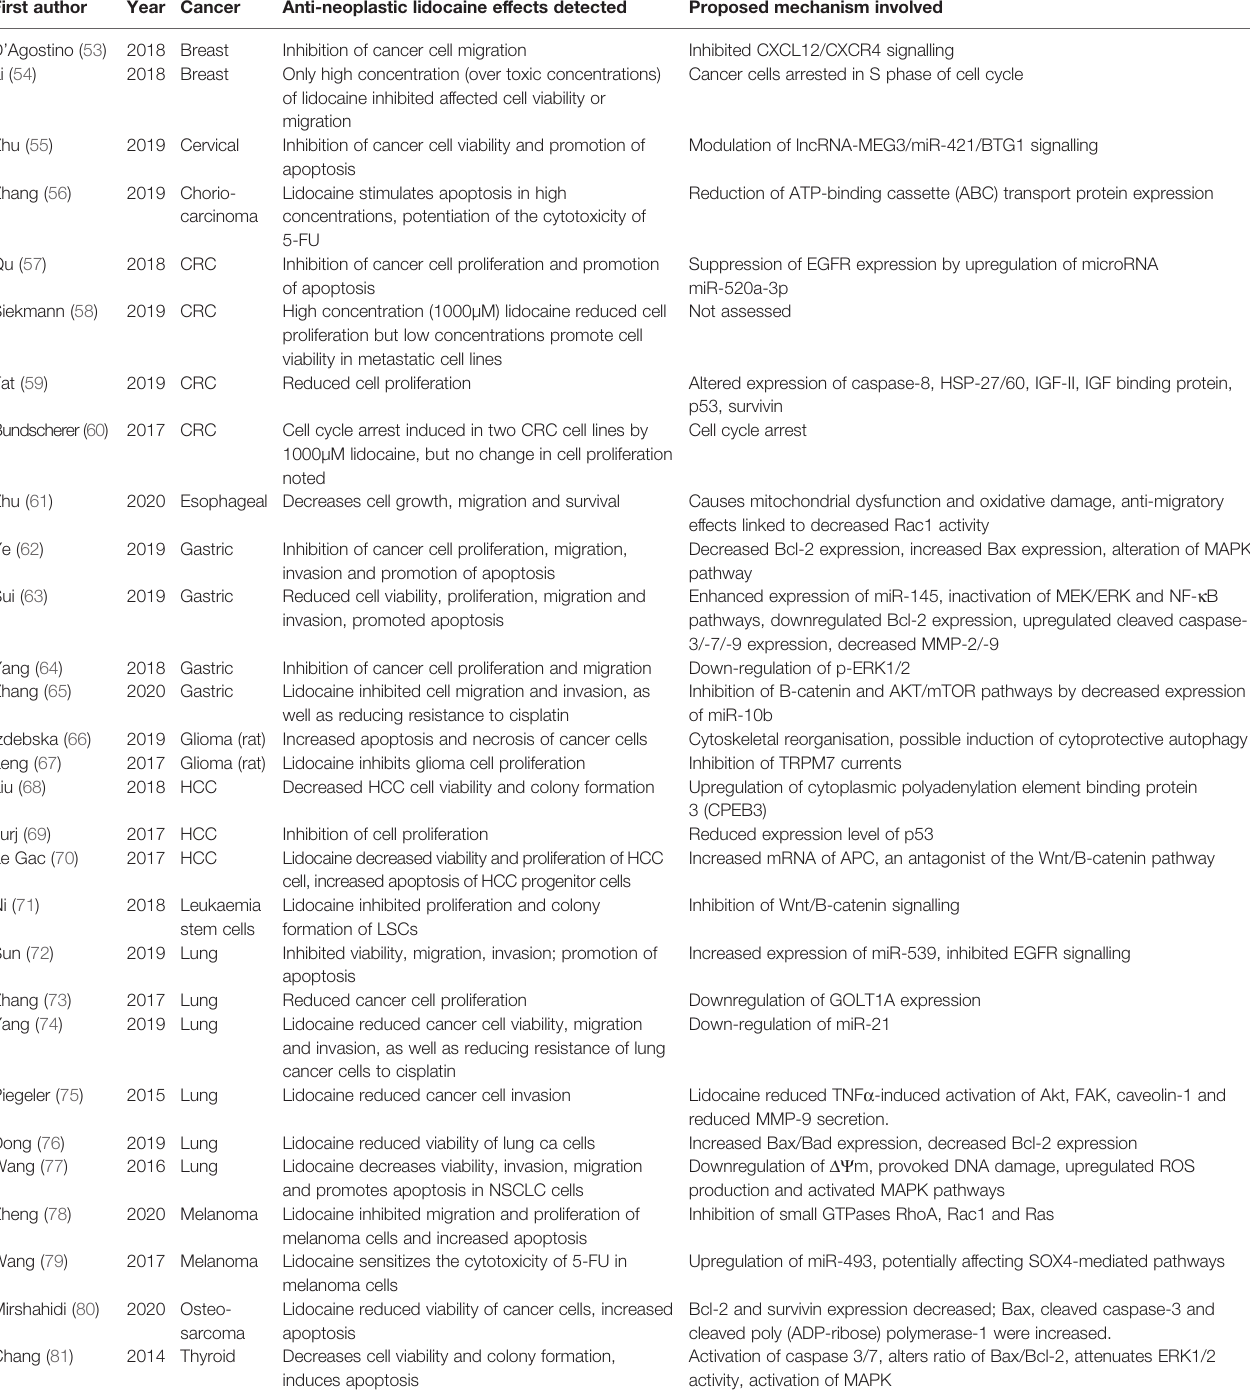
TABLE 1 | Selected in vitro studies examining the effects of lidocaine treatment on cancer cell